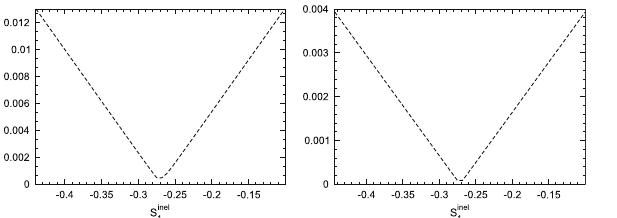
( S inel ) as a function of S inel 0 1